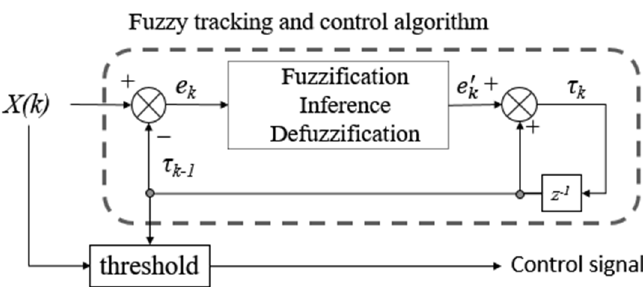
Figure 3. Structure of fuzzy tracking and control algorithm. The variable z − 1 is a unit delay for the next step.